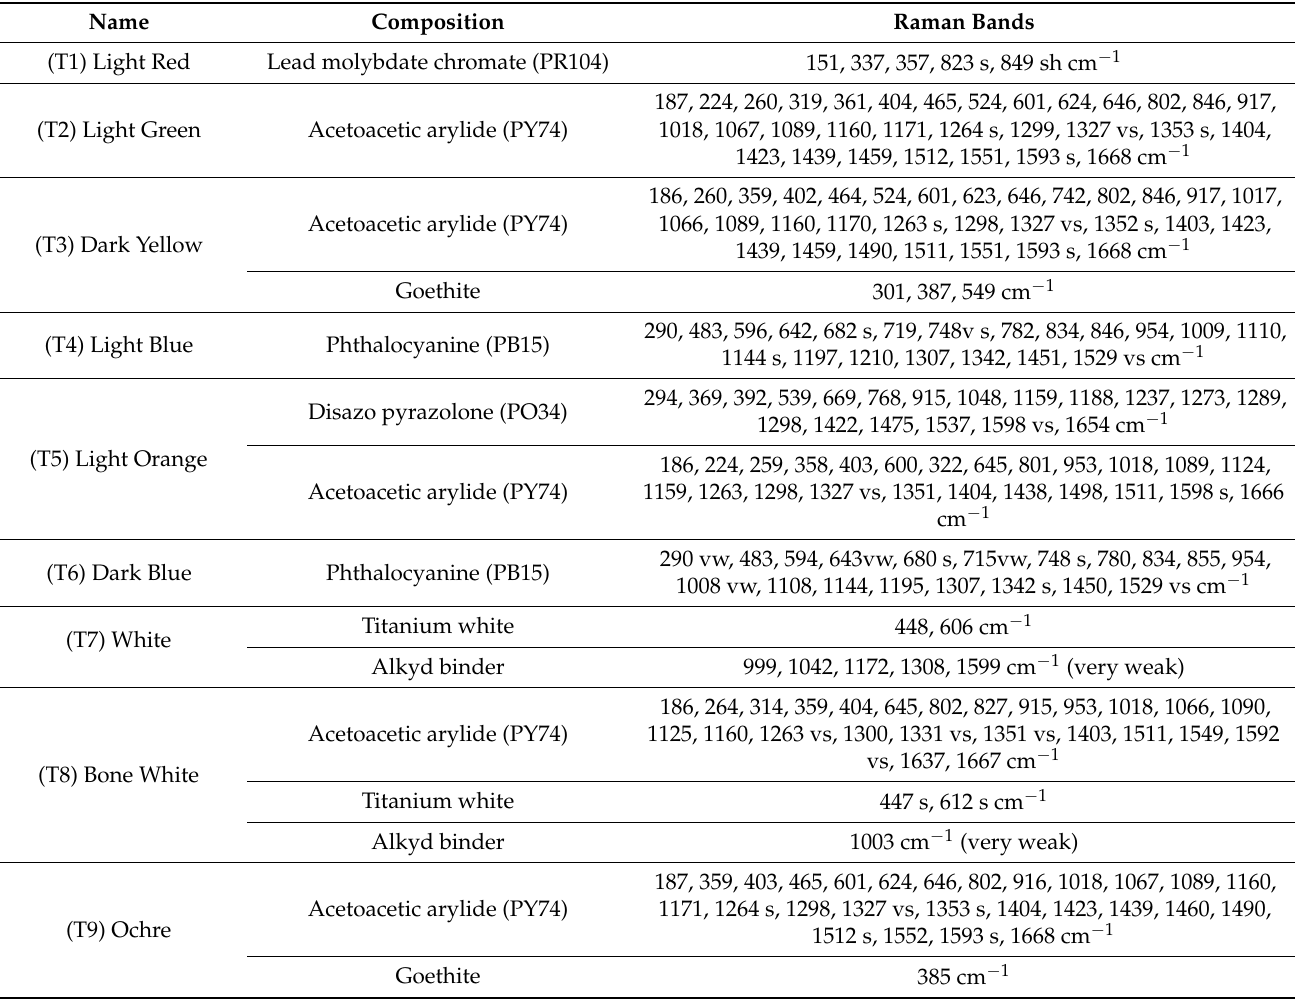
Figure 5. Raman spectra of the sampled inks in the main hall of the Punta Begoña Galleries, with T1 being the most external layer, and T12 the innermost layer. Table 4. Compounds identified by means of Raman spectroscopy in the main hall samples.